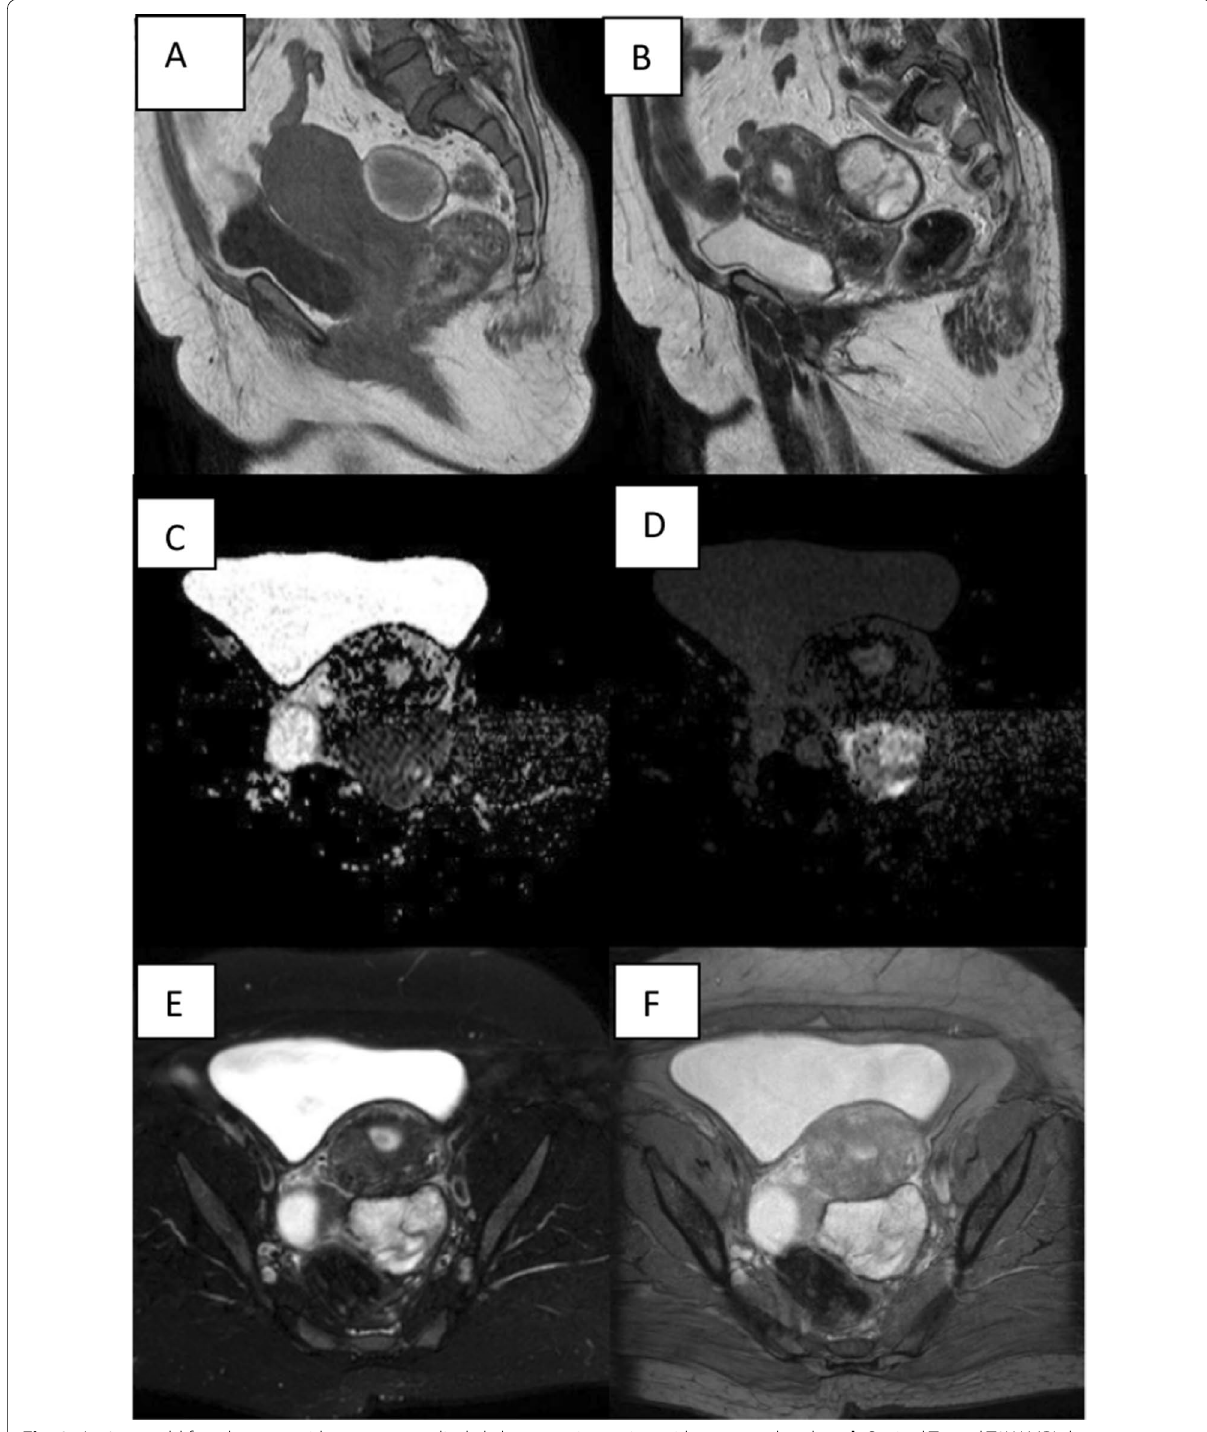
Fig. 2 A 40 year old female came with recurrent cyclical abdomen pain varying with menstrual cycle. a , b Sagittal T1 and T2W MRI shows well defined cystic lesion seen in the posterior fornix and torus uterinus. The lesion appears T1-Hypointensity and T2- Hyperintensity, probably originating from the left ovary. Left ovary not seen seperately. c , d ADC and DWI axial image demonstrating few areas of T2 shadowing and the lesion shows Restricted diffusion, e T2 fat suppression axial section which appears hyperintense. No evidence of fat suppression. f on FFE sequence, complete hemosiderin rim seen.MR Imaging features suggestive of endometrioma arising from the left ovary, confirmed by